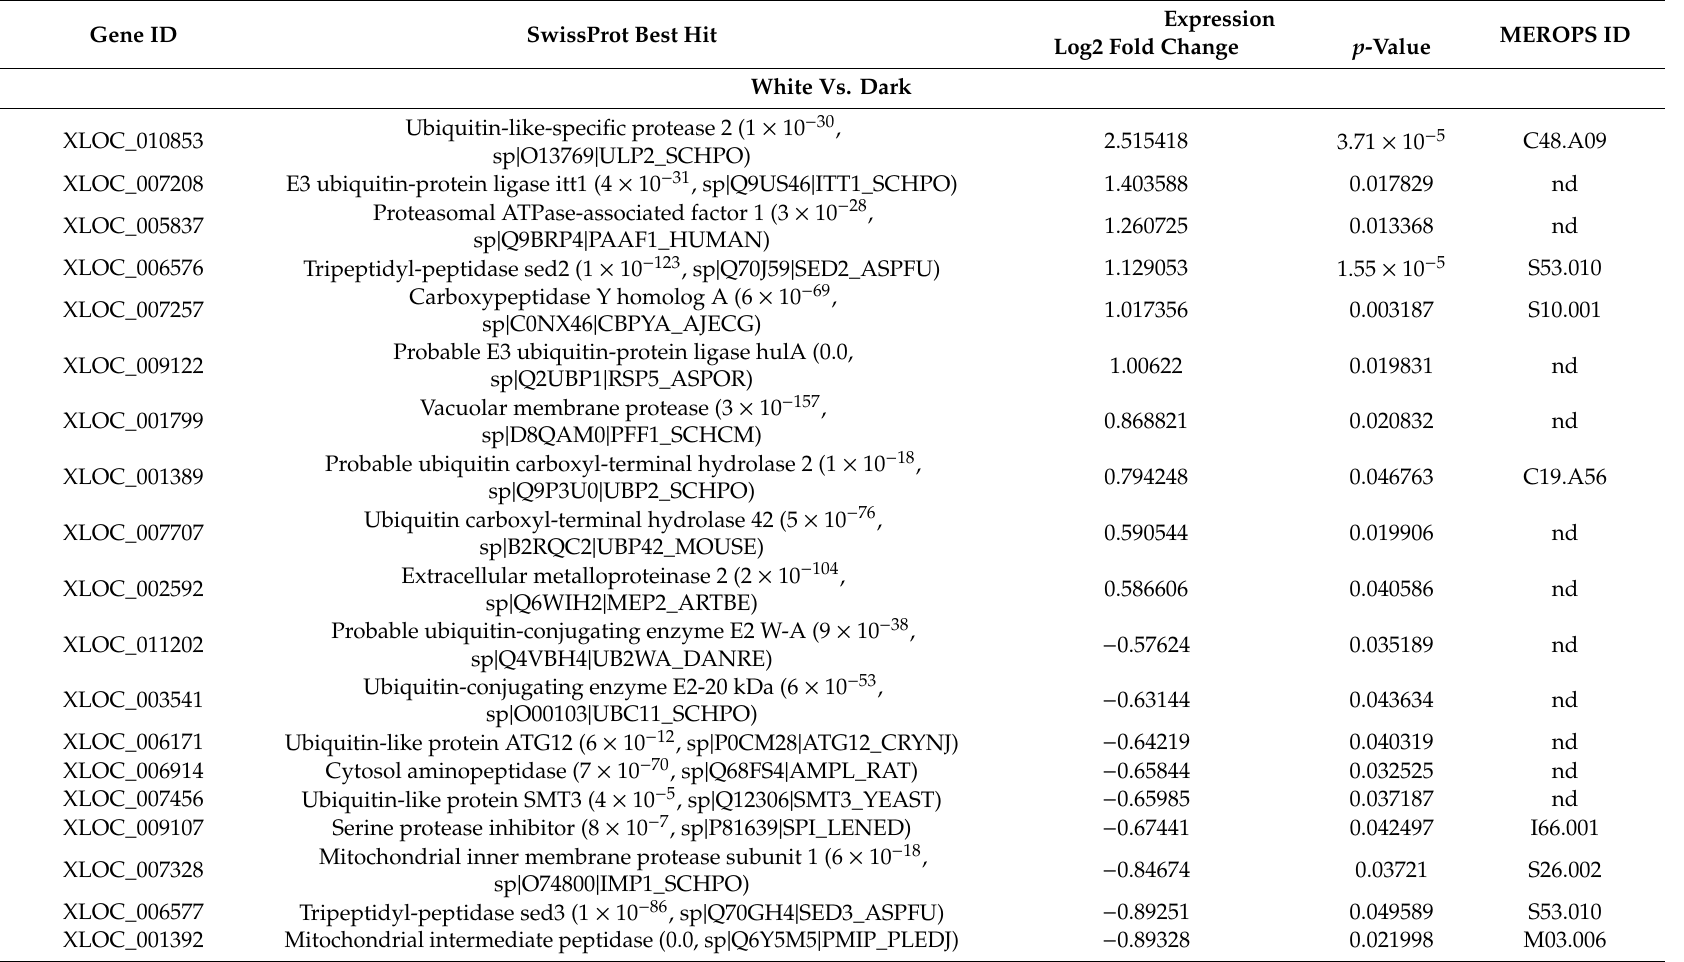
Table 1. C. unicolor DEGs Encoding for Putative Proteolytic and Proteasomal Activities Detected during Fungus Growth in Di ff erent Lighting